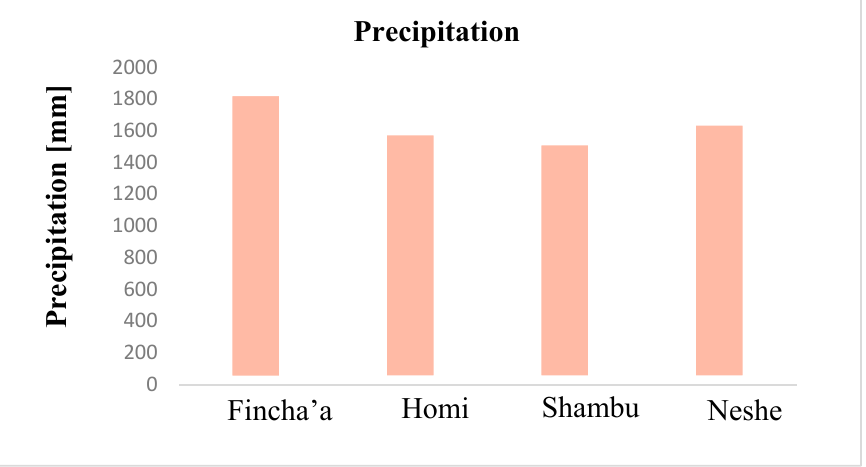
Figure 5. Annual precipitation measured in the four stations during the period 1994–2018. The double mass curve technique was used to check whether the collected rainfall data from the Fincha’a sub-basin meteorological station were consistent through the selected period of study and checked whether corrections were needed or not. A group of certain numbers of neighbouring stations were chosen as base stations from the vicinity of a doubtful station and were considered a doubtful station until checked. The precipitation of station x (doubtful station) can be corrected using Equation (1):